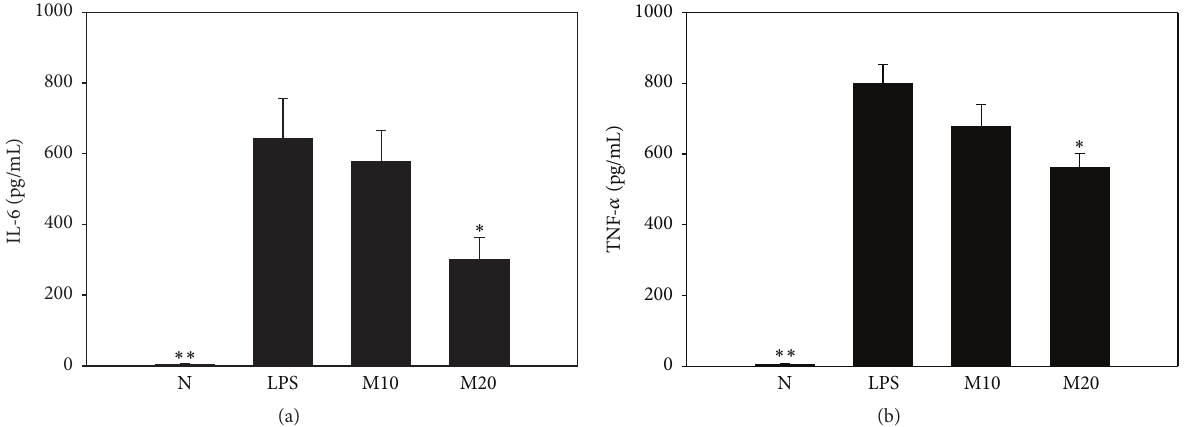
Figure 9: Matrine affects the serum levels of inflammatory cytokines, including IL-6 (a) and TNF- 𝛼 (b). All data are presented as means ± SEM. ∗ 𝑃 < 0.05 compared with the LPS control